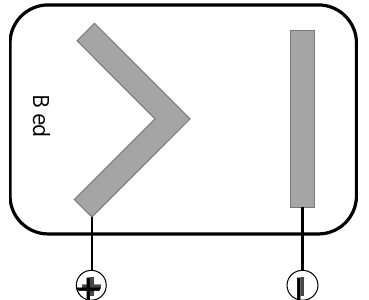
Figure 2. The configuration of the cECG on a bed. Two belt-shape electrodes were made from conductive fabric.